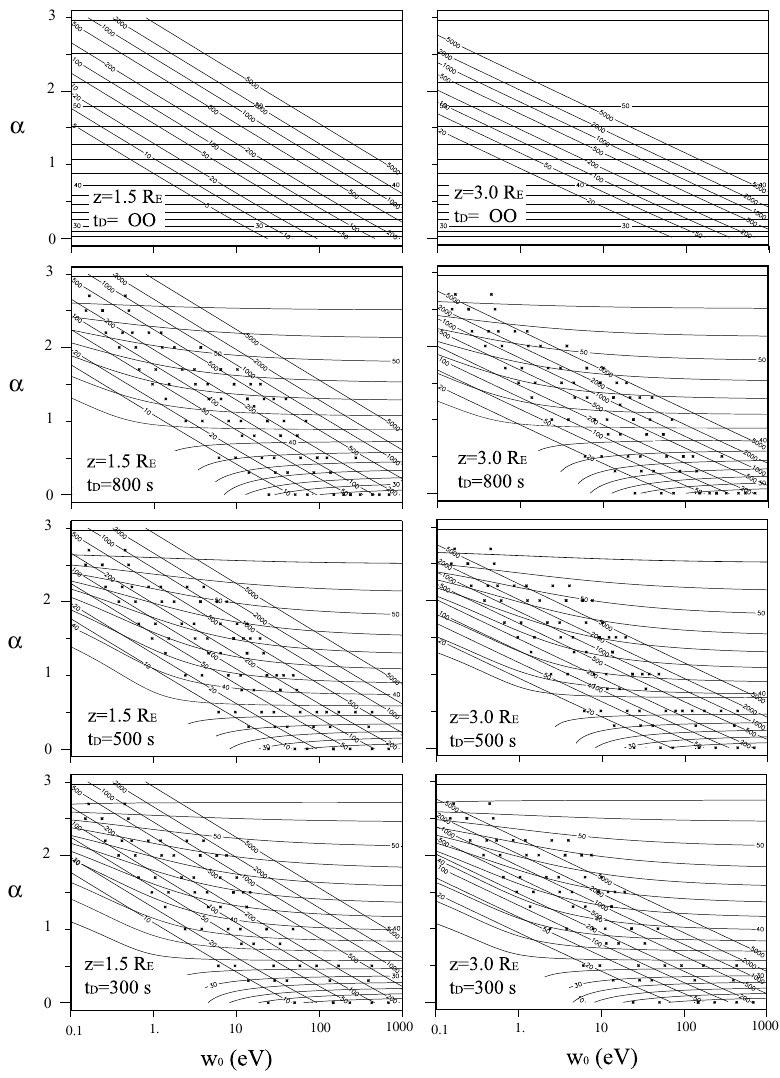
Fig. 14. Patterns in a plane w 0 − α of the apex and the mean perpendicu- lar energy of O + ions at the poleward edge of the heating region at two alti- tudes: 1.5 R E (left) and 3 R E (right). The oblique curves correspond to con- tours of the mean perpendicular energy (in eV) while the curves approximately horizontal correspond to contours of the apex with a constant step of 2 ◦ . Crosses correspond to values inferred from nu- merical